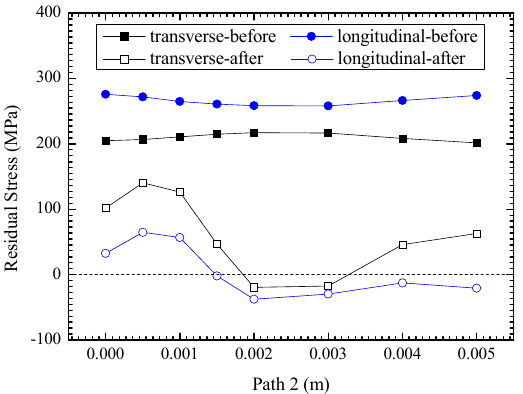
Figure 10. Comparison of the residual stress distributions before and after UIT along Path 2. Materials 2020 , 13 , x FOR PEER REVIEW